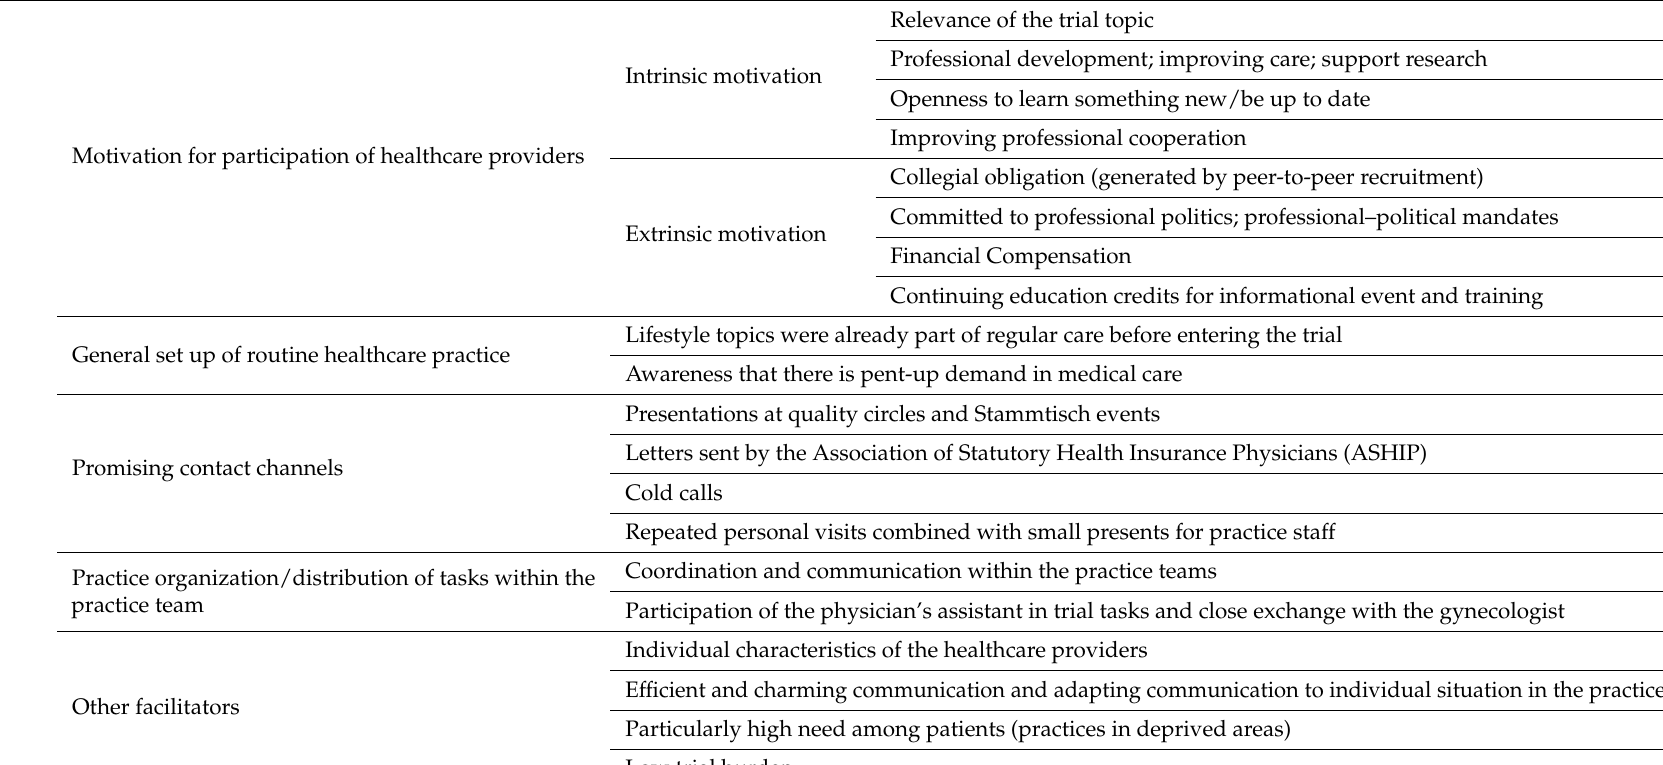
Table 1. Category system for thematic